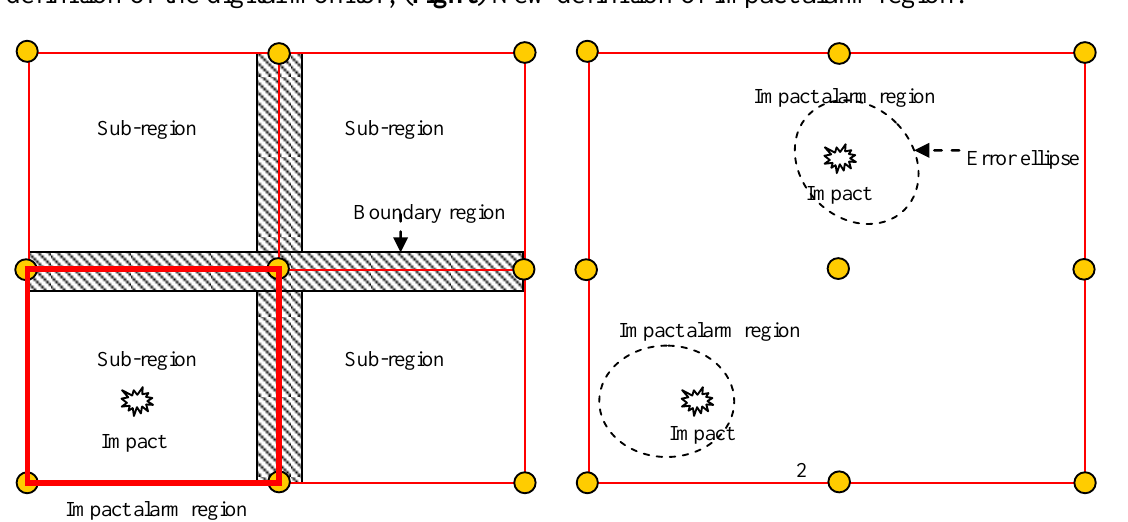
Figure 3. Illustration of new definition of impact alarm region. ( left ) Impact alarm region definition of the digital monitor; ( right ) New definition of impact alarm